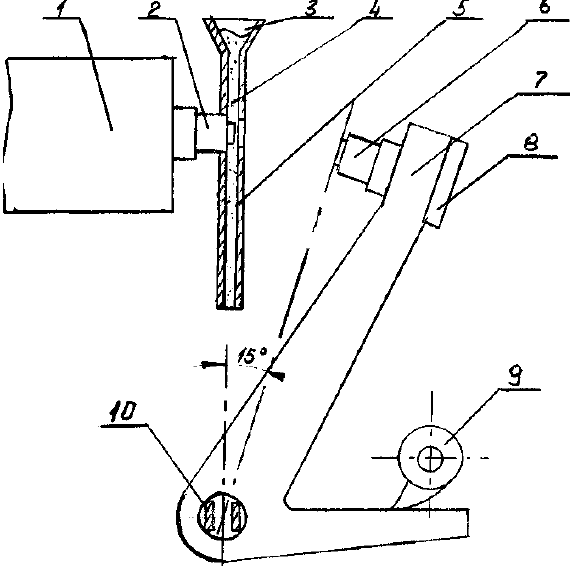
Figure 2. Sketch of the testing machine for the impact-abrasion wear testing (designations are explained in the text).